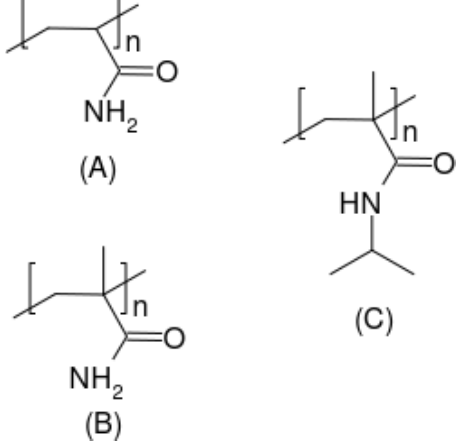
Figure 8. Chemical structure of ( A ) polyacrylamide, ( B ) polymethacrylamide, and ( C )